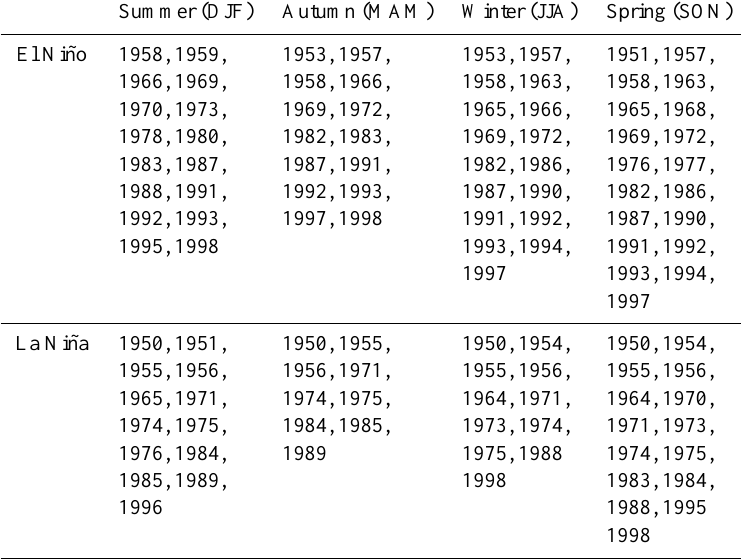
Table 1. El Ni˜no and La Ni˜na